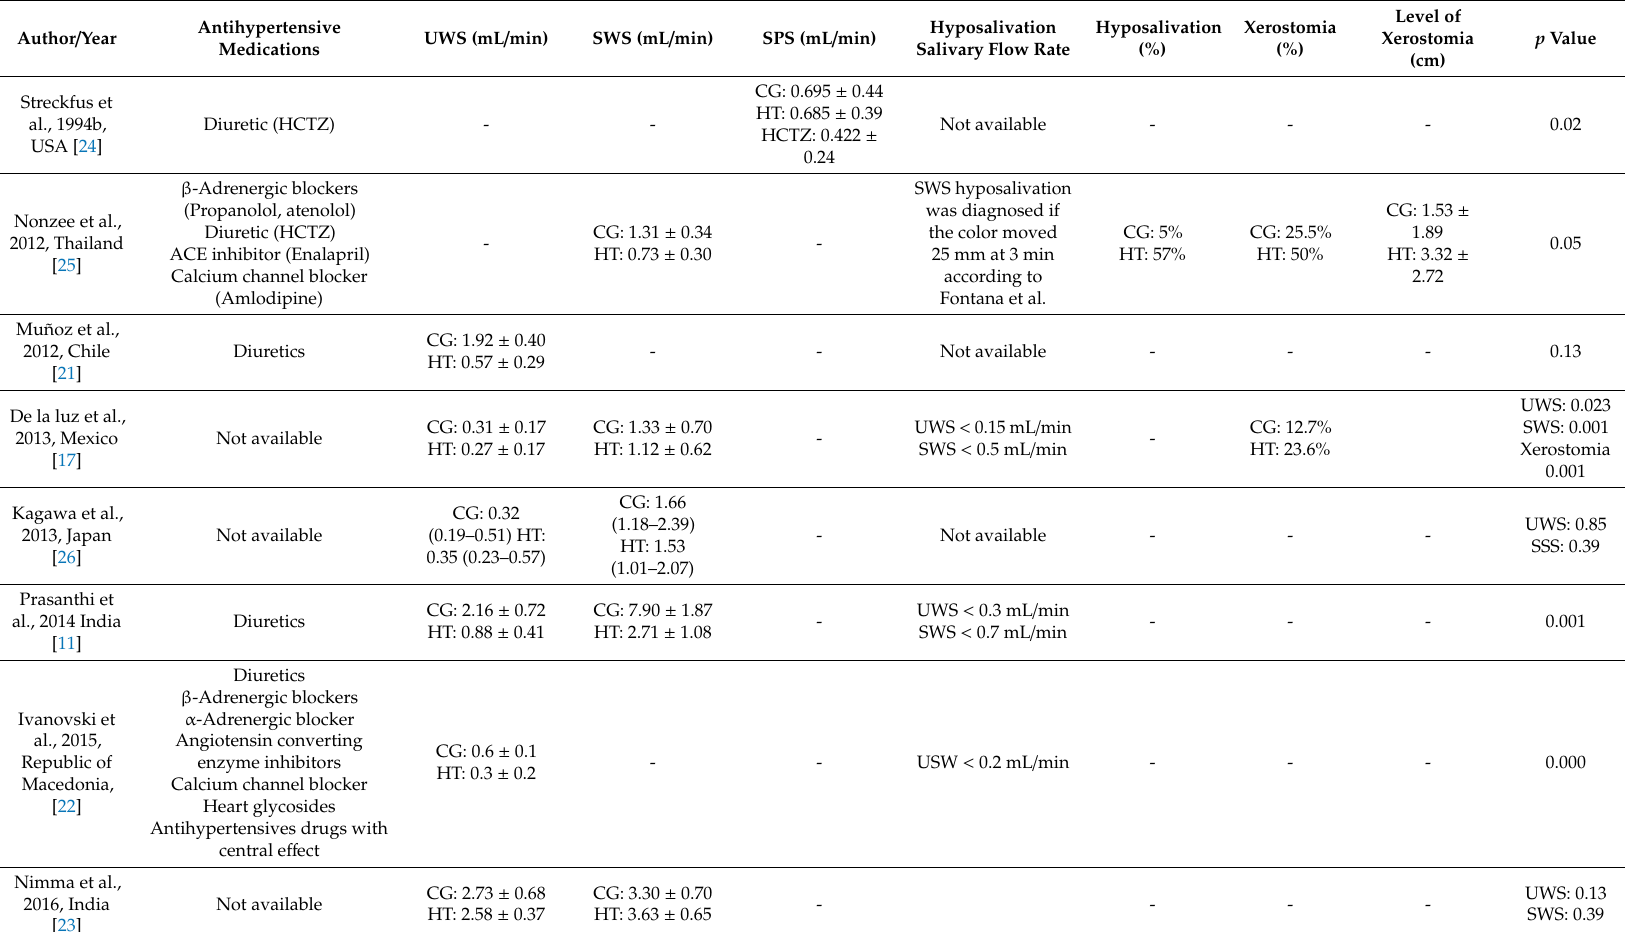
Table 5. Case-control studies